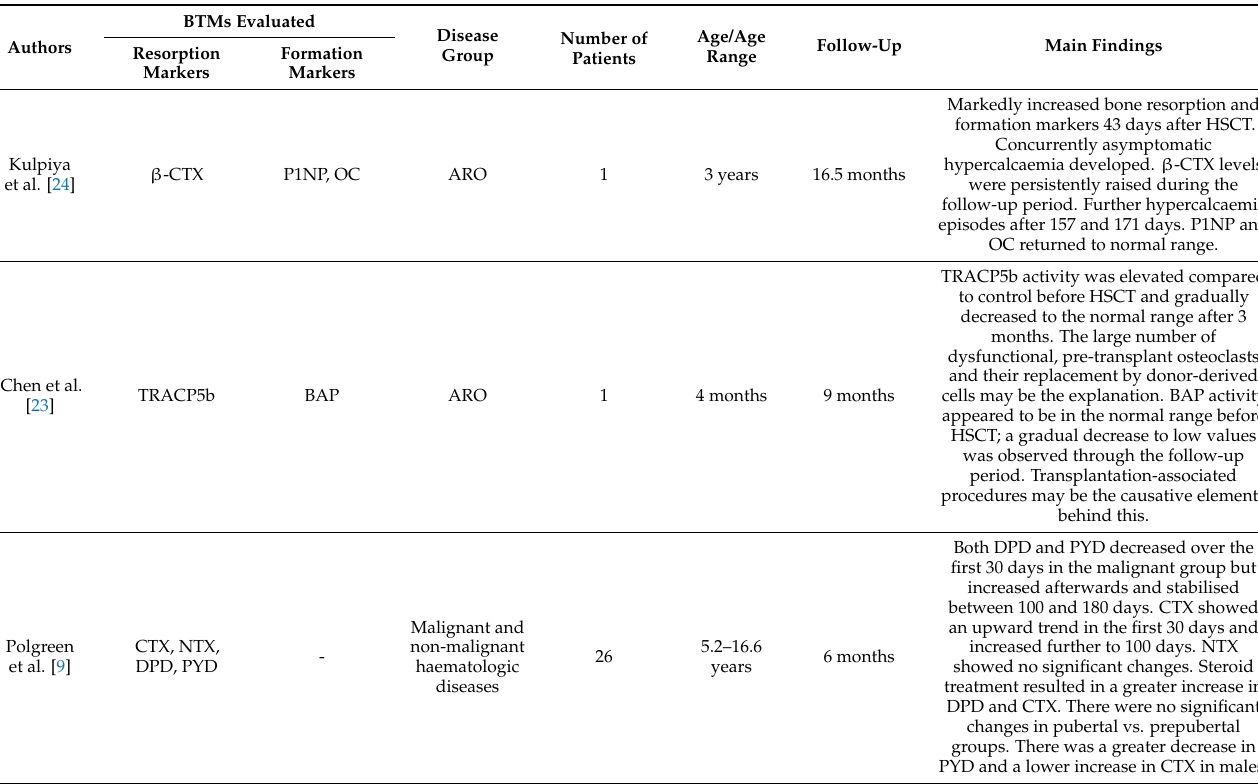
Table 2. Studies and case reports related to the bone turnover marker profile of paediatric patients undergoing